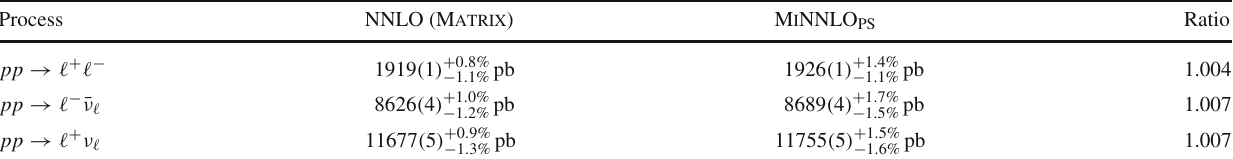
Table 1 Total cross sections of the Drell Yan production processes. The number in brackets denotes the numerical uncertainty on the last digit Process NNLO ( Matrix )